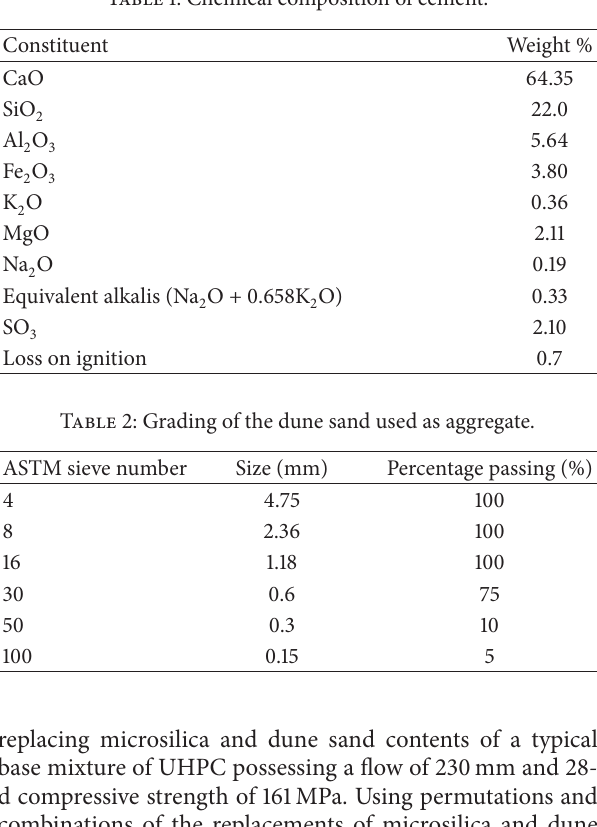
Table 1: Chemical composition of cement.